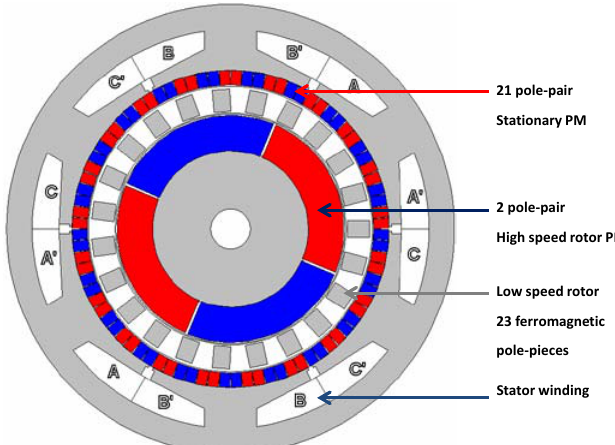
Figure 1. Radial cross-section of the Pseudo Direct Drive